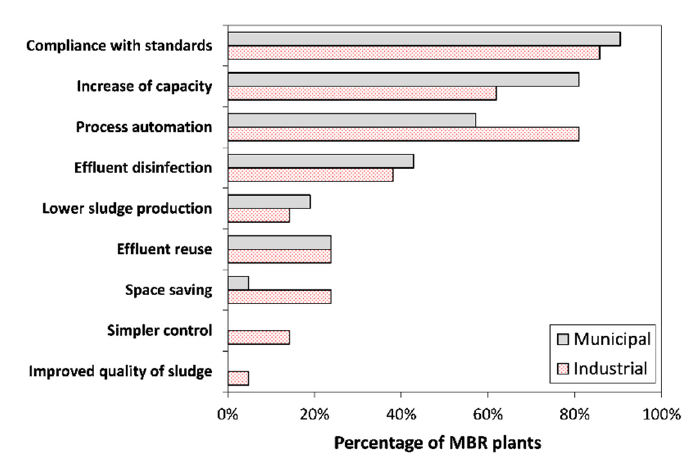
Figure 6. Operational advantages of MBR technology.